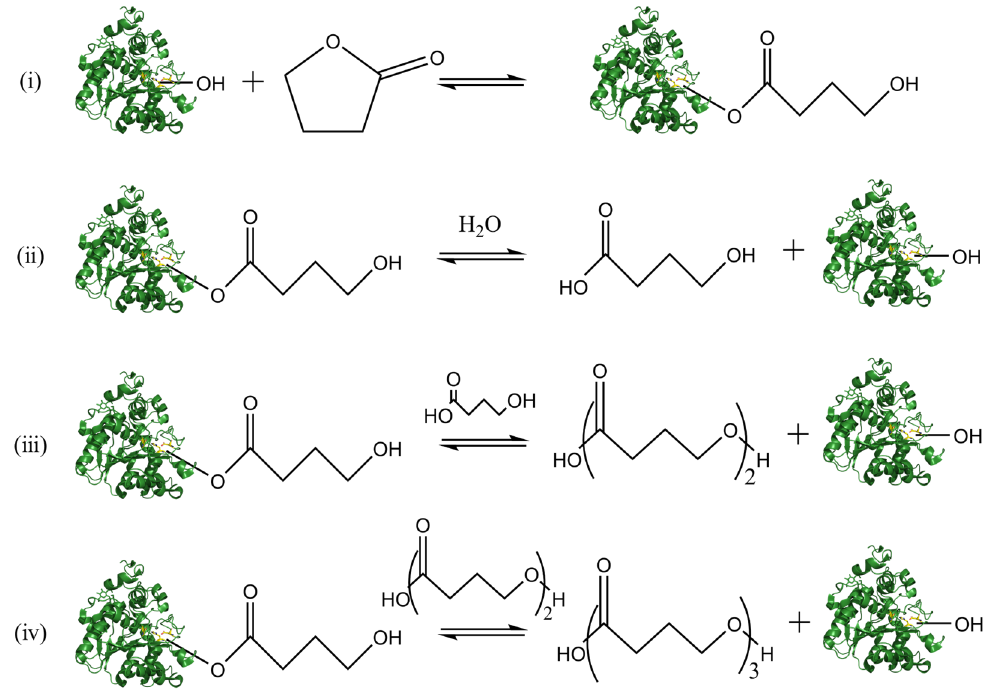
Figure 6. Lipase-catalyzed ring-opening polymerization (in the case of butyrolactone, butyrolactone is polymerized by eROP). ( ⅰ ) the formation of enzyme-substrate active intermediate, ( ⅱ ) the hydrolysis of enzyme-substrate active intermediate, ( ⅲ ) the formation of dimer, ( ⅳ ) the formation of triploid. Structures of lipases were rendered using PyMOL [80] . The copyright detail is shown in supplementary material.